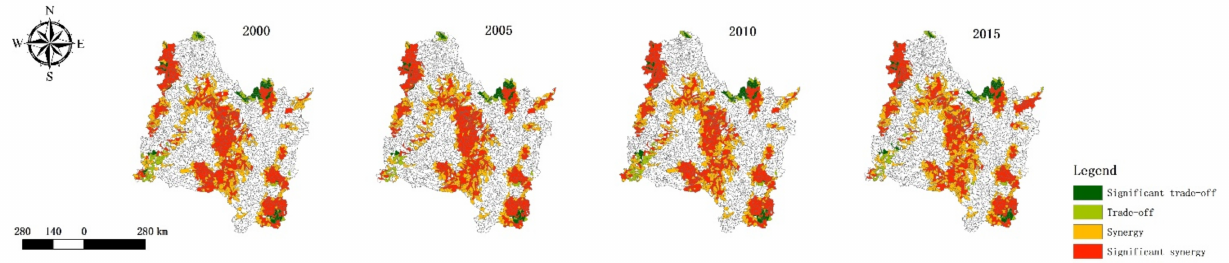
Figure 13. The synergy/trade-off relationship between soil conservation and biodiversity. The synergy/trade-off relationship between soil conservation and carbon sequestra- synergy/trade-off relationship between soil conservation and carbon sequestration is